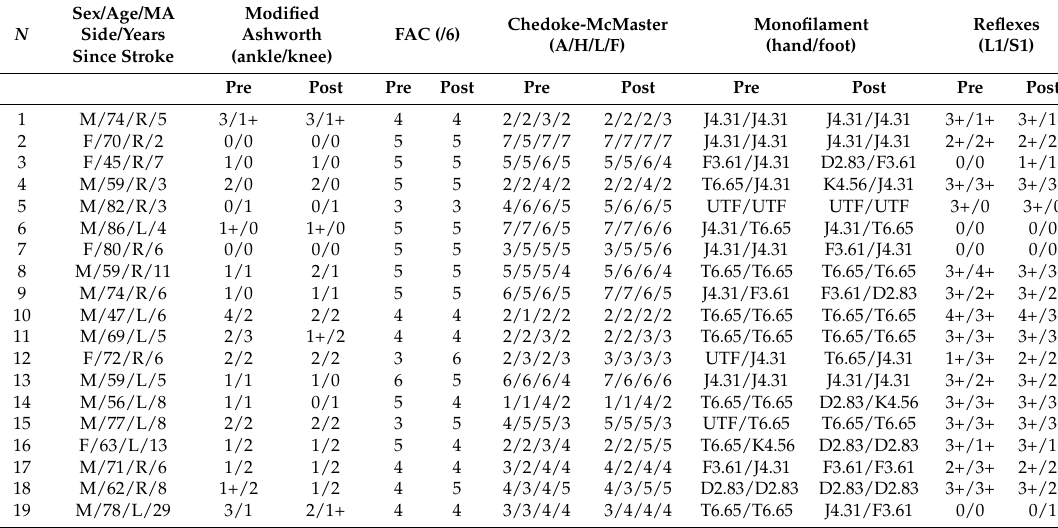
Table 1. Summary of participant demographics and results from tests assessing clinical status including a test for muscle tone (modified Ashworth), functional ambulation (FAC), physical impairment (Chedoke–McMaster scale), touch discrimination (monofilament test), and reflex function for stroke participants before and after arm and leg (A & L) cycling